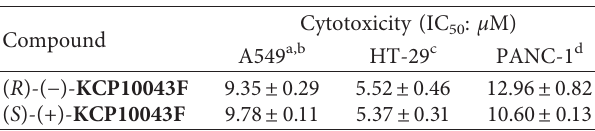
Table 2: Cytotoxicity of racemate ( ± )-KCP-10043F and its two enantiomers against human cancer cell lines.